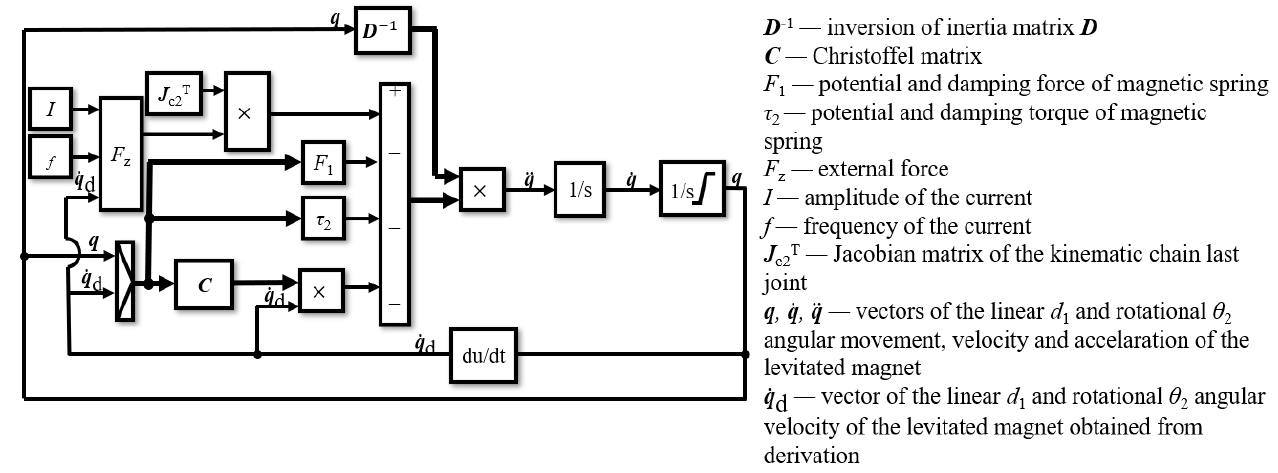
Figure 7. Block diagram by Simulink/Matlab of the magnetic spring and vibration generator simu- lation model.